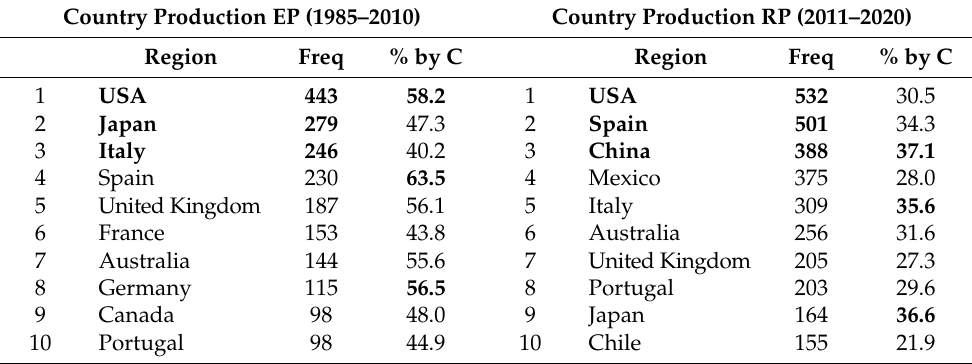
Table 3. Information on production of the first ten most productive countries ordered by the total number of publications (freq) from 1985 to 2010 (“earlier period”: EP) and from 2011 to 2020 (“recent period”: RP). The first three items are in bold. C: corresponding author.